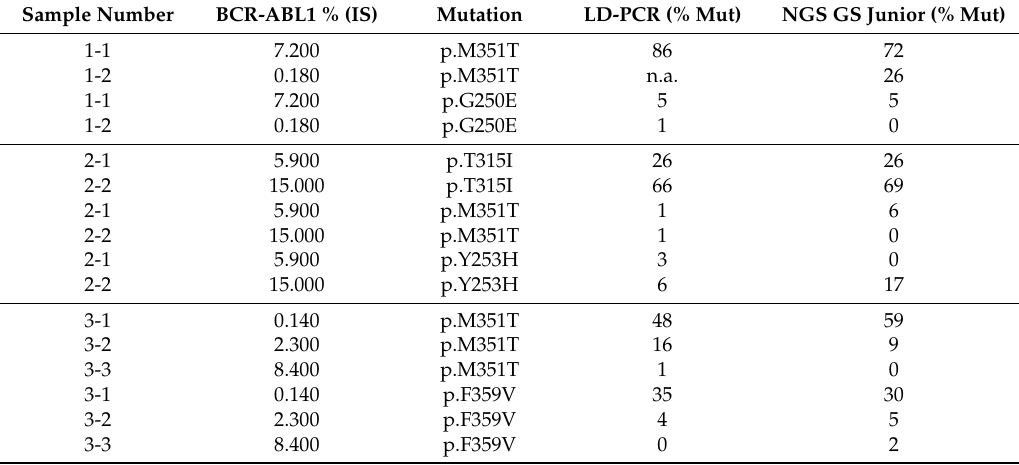
Table 2. Displayed are serial specimens from three CML patients, each carrying two or more different mutant subclones, which were analyzed by LD-PCR and NGS on the GS junior platform (Roche). n.a., not